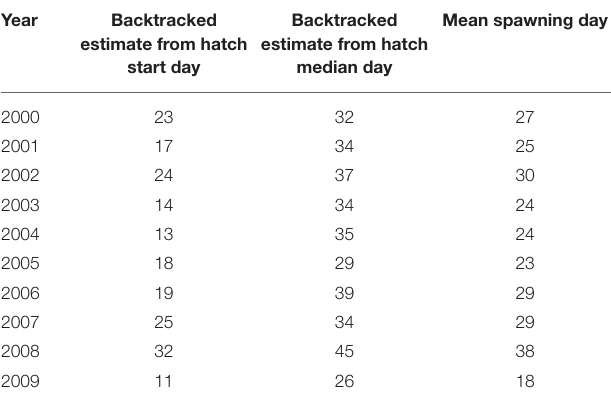
TABLE 4 | Estimates of spawning days between 2000 and 2009. Shown are the spawning start days, spawning end days, and mean spawning days. Year Backtracked Backtracked estimate from hatch estimate from hatch start day median